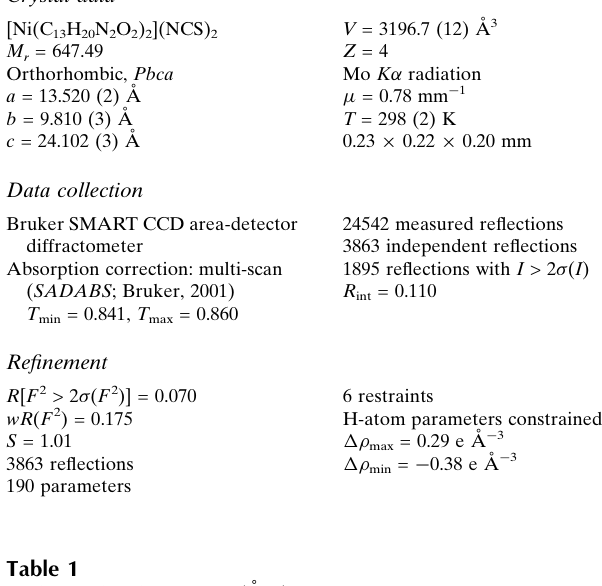
Hydrogen-bond geometry (A˚ , (cid:4)